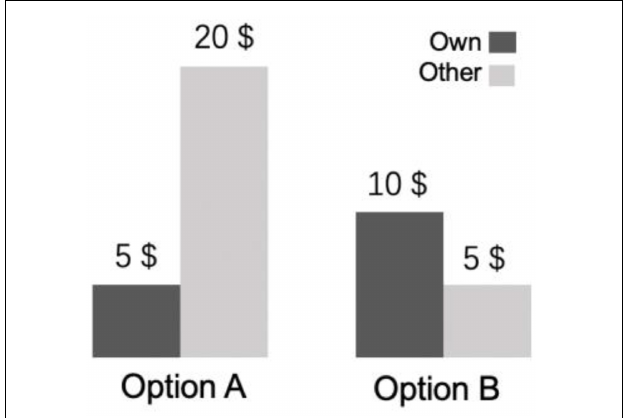
FIGURE 2 | The percentage of altruistic choices among different groups. Participants who underwent tDCS of the dmPFC exhibited a significantly higher percentage of altruism than did those who underwent sham stimulation ( p = 0.016) or tDCS of the rTPJ ( p = 0.001), whereas no significant different was identified between the rTPJ experimental group and control group ( p = 0.377). Error bars indicate ± 1 standard error of mean. Asterisks indicate significance levels: * p < 0.05; ** p <